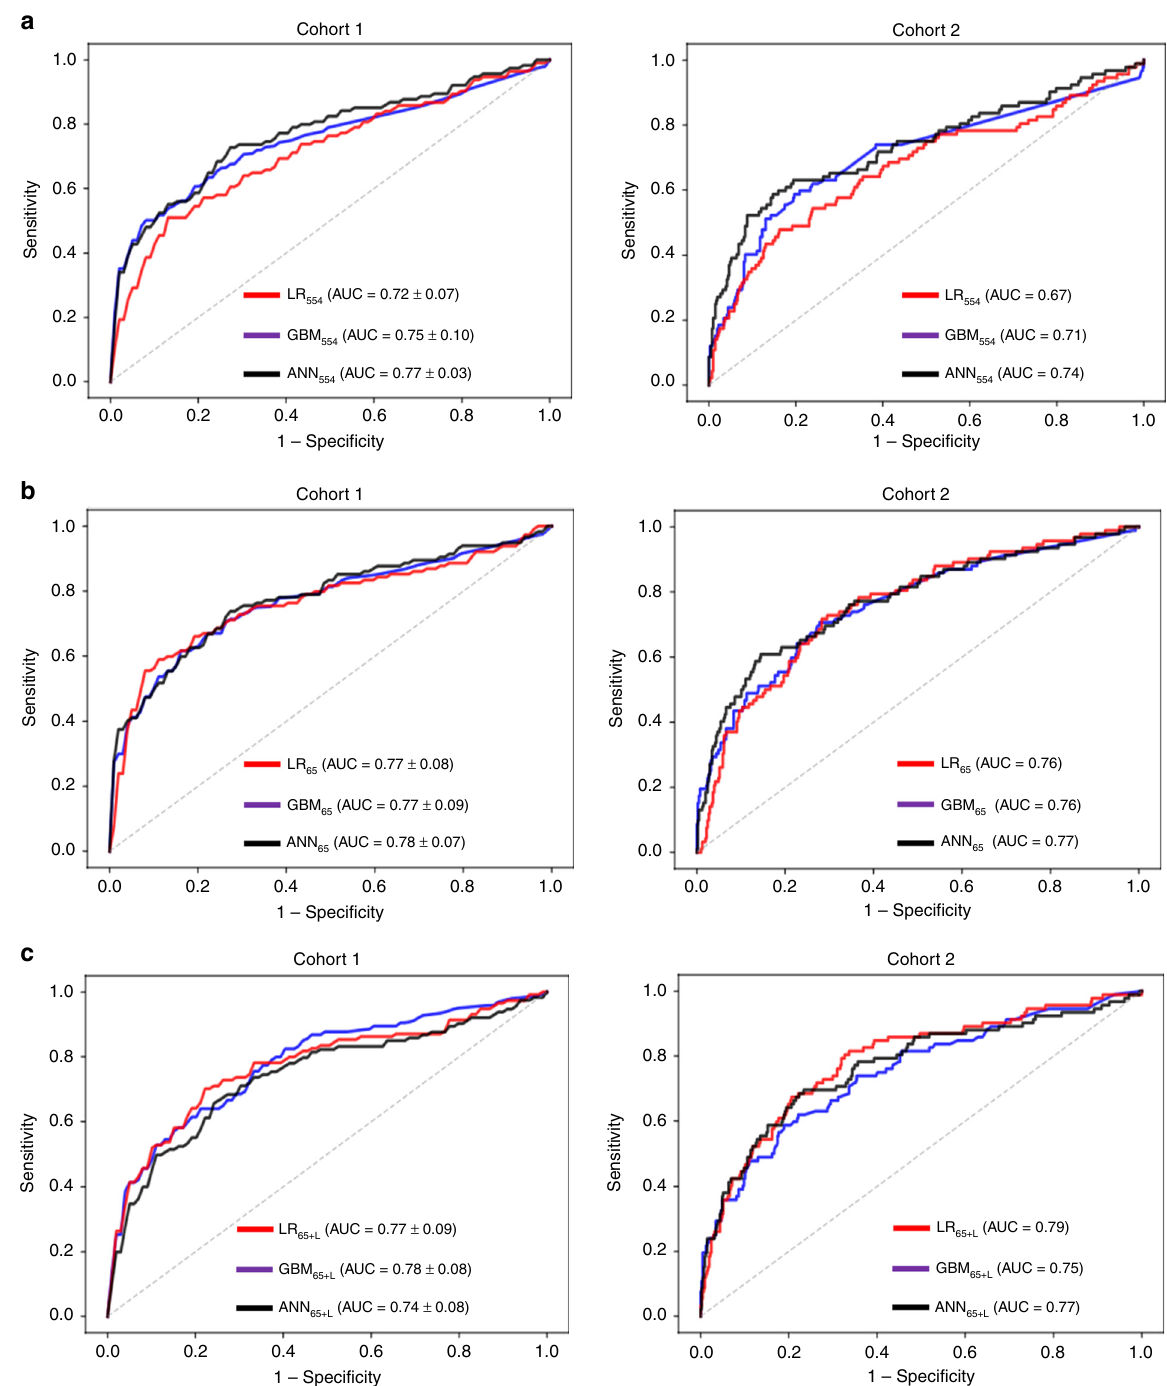
Fig. 2 Classi fi cation performance using machine learning classi fi ers. This fi gure shows the ROC curves of logistic regression (LR), gradient boosting machine (GBM), and arti fi cial neural network (ANN) classi fi ers using a all available ECG features ( k = 554), b selected ECG features ( k = 65), and c selected and relabeled ECG features ( k = 65 + L). Cohort 1 was used for training with tenfold cross-validation, the fi gure shows mean ROC curve with ±2 standard errors. Cohort 2 was used for independent testing using the algorithm trained on Cohort